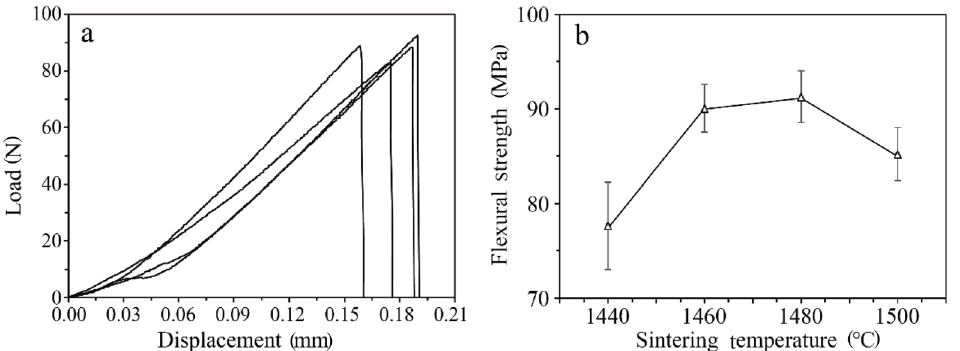
Fig. 4 Flexural strength of porous ceramics at RT: (a) load–displacement curves of samples sintering at 1480 ℃ , (b) flexural strength.